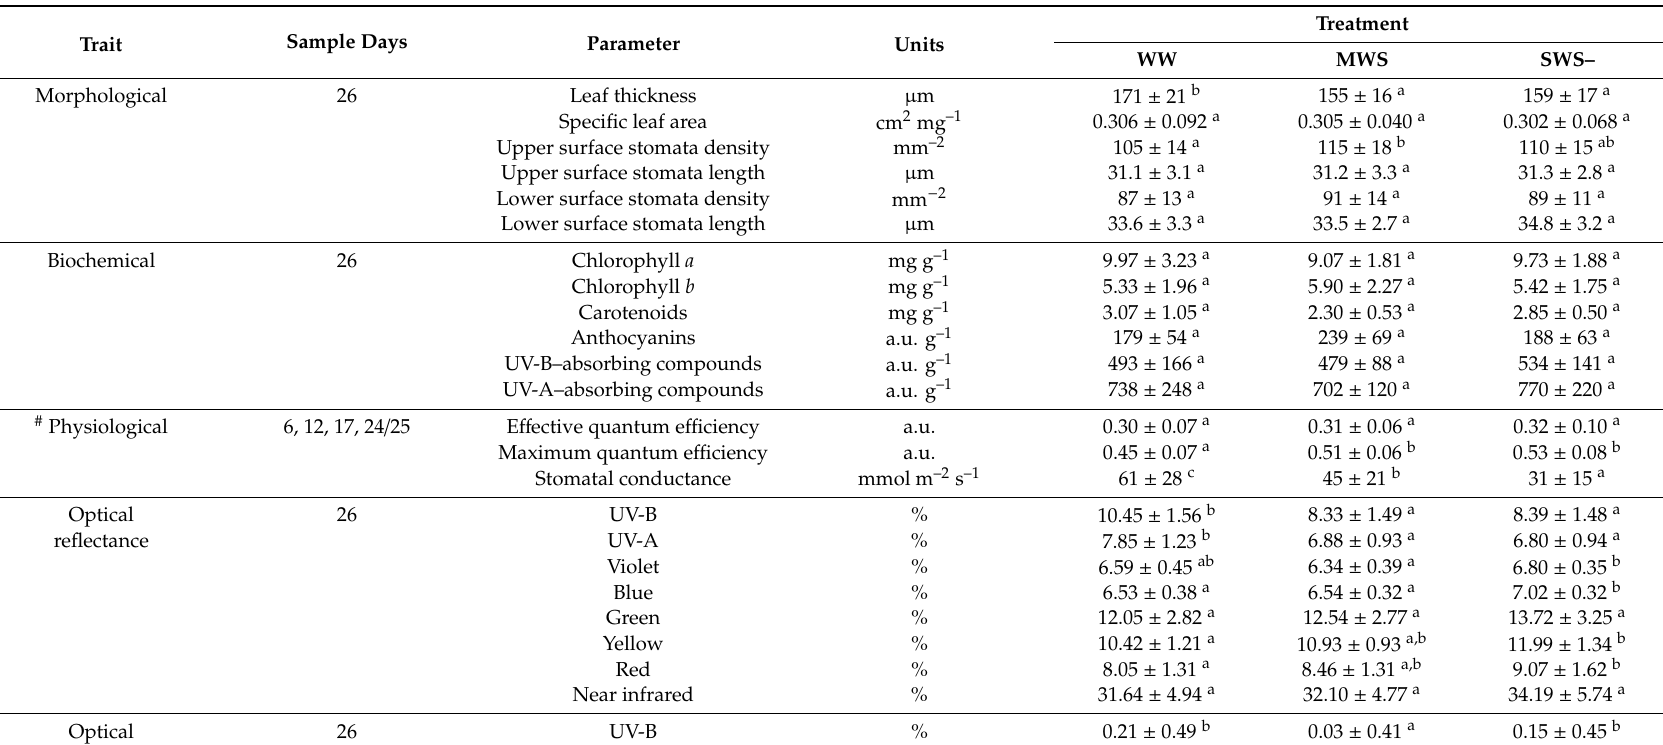
Table 1. The proso millet leaf and plant parameters recorded under the di ff erent water treatments in this study.